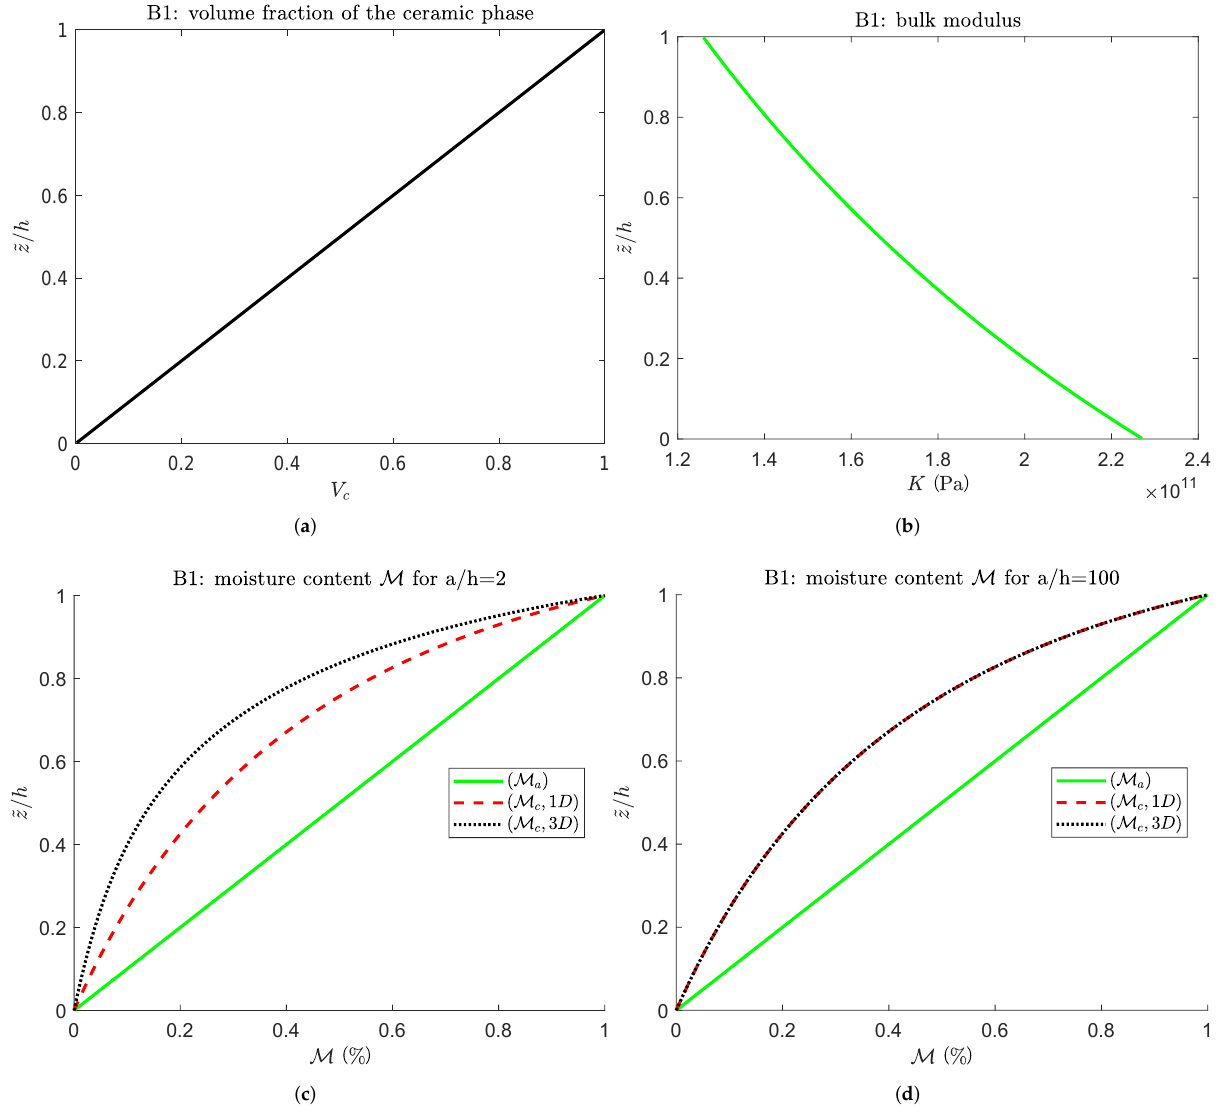
Figure 3. First benchmark: one-layered FGM ( p = 1) square plate with an imposed moisture content on the top and bottom surfaces. The figures show the volume fraction of the ceramic phase, the bulk modulus, and the moisture content profiles for a thick and a thin structure through their thickness. ( a ) Volume fraction of the ceramic phase V c . ( b ) Bulk modulus K. ( c ) Moisture content profile of the a / h = 2 plate. ( d ) Moisture content profile of the a / h = 100